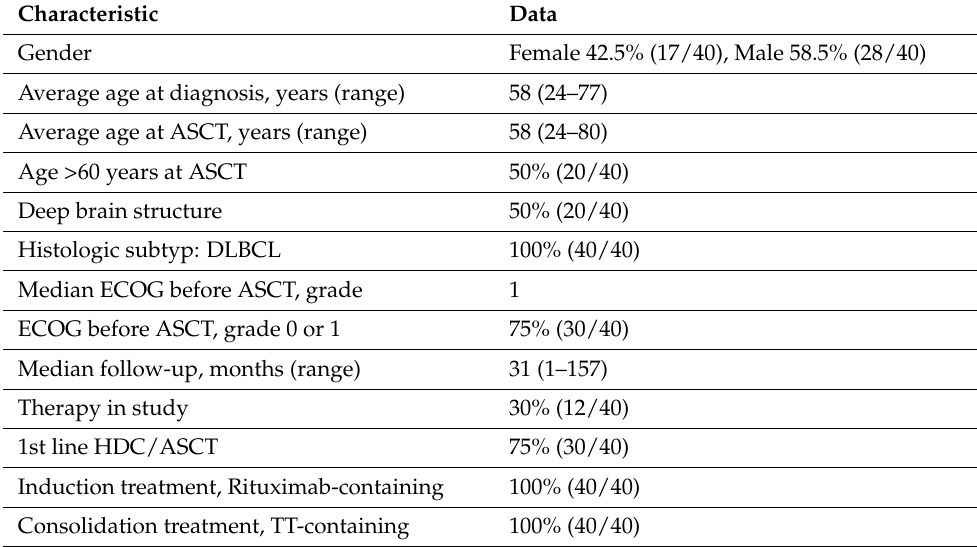
Table 1. Patient characteristics in the whole cohort ( n = 40).